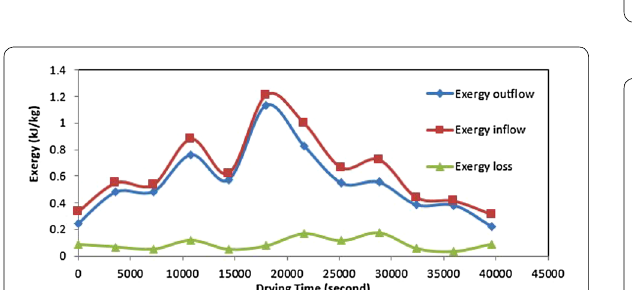
Fig. 8 Exergy as a function drying time (2nd day) potato